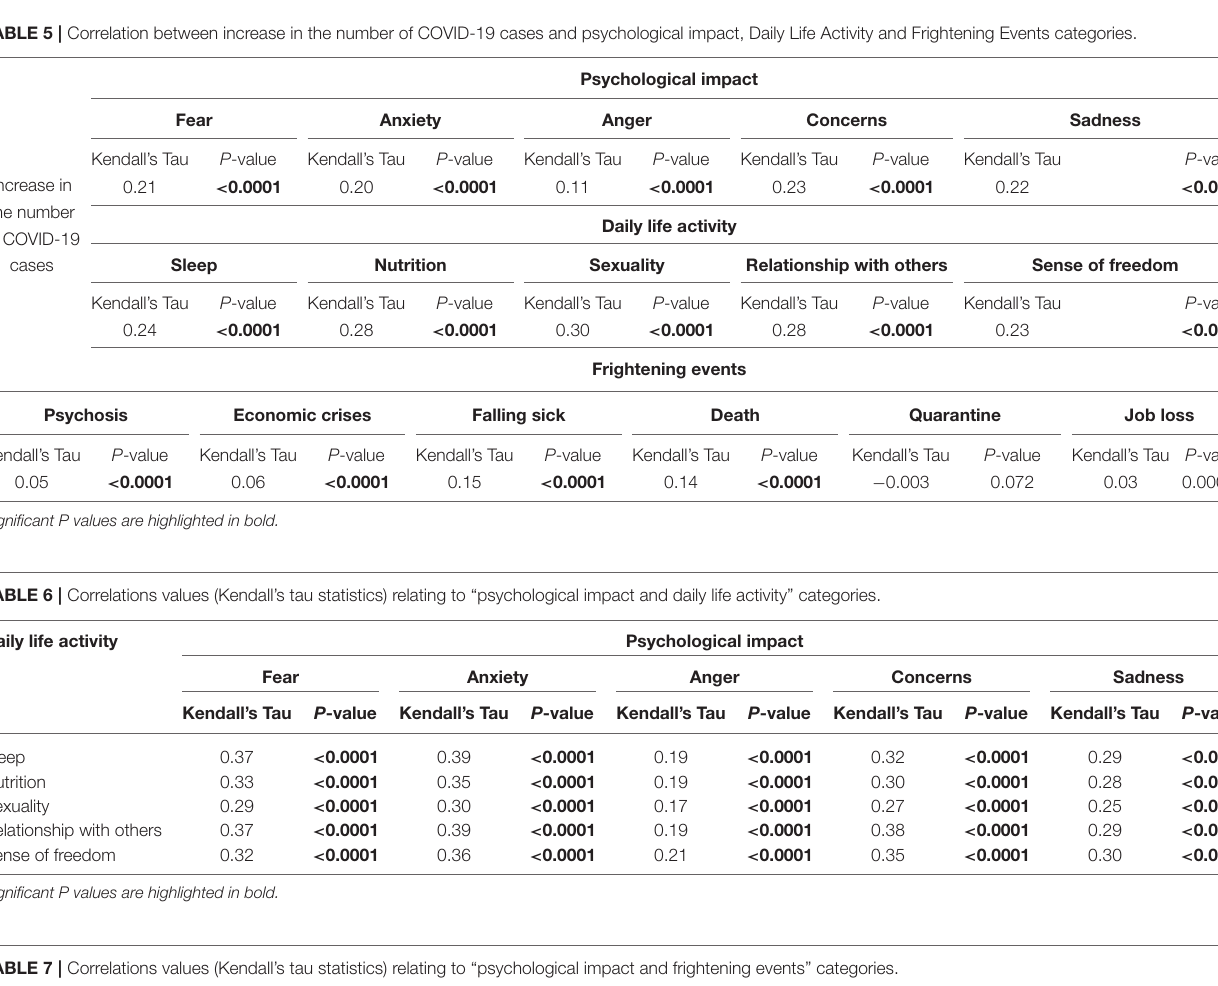
TABLE 5 | Correlation between increase in the number of COVID-19 cases and psychological impact, Daily Life Activity and Frightening Events categories.